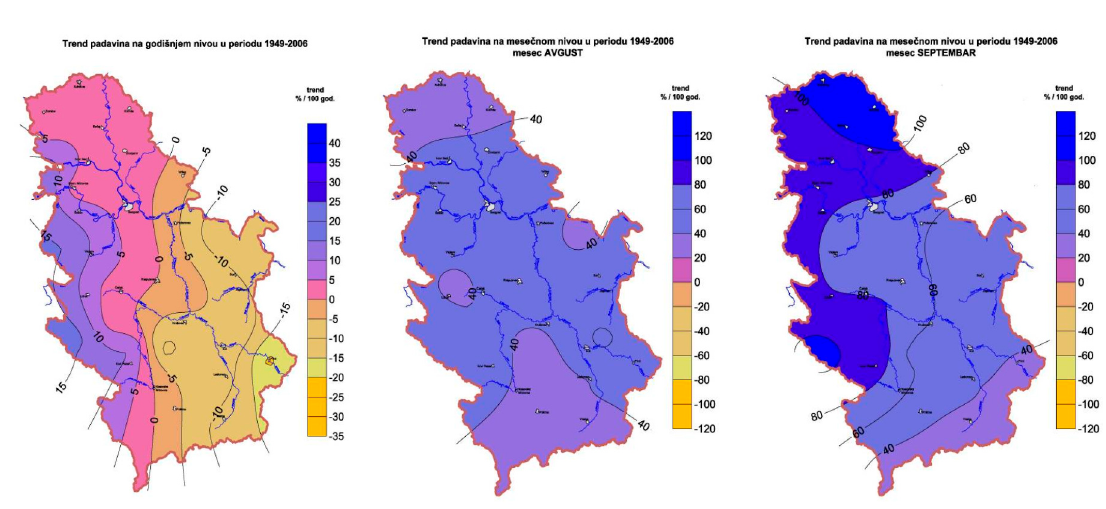
Figure 4. App. long-term annual and monthly for August and September precipitation trends